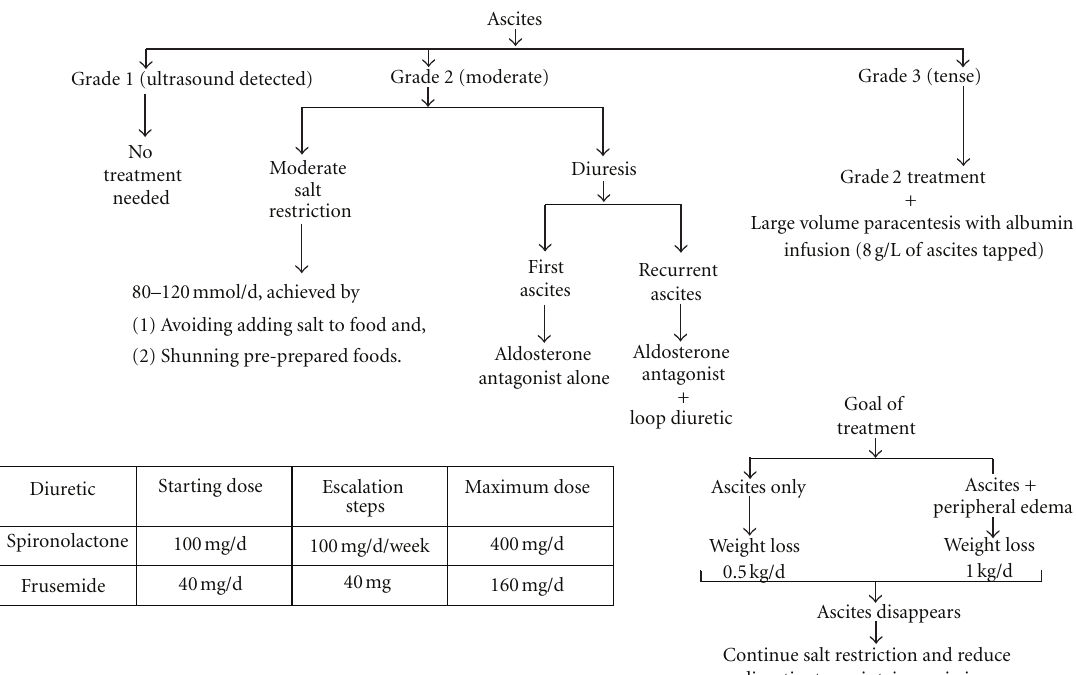
Figure 2: Approach to management of uncomplicated